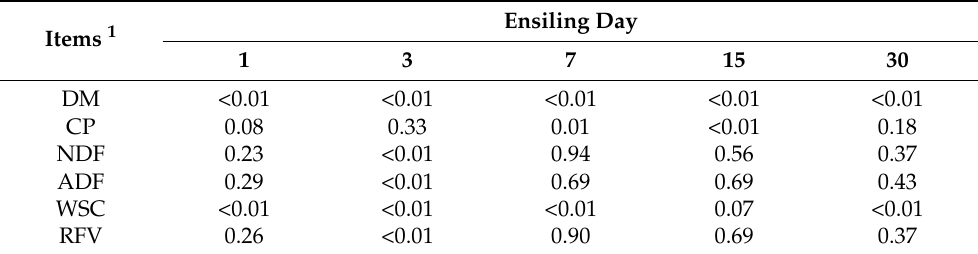
Table 4. Statistical analysis for the chemical composition variables of alfalfa silage treated with different carbohydrate sources at different ensiling